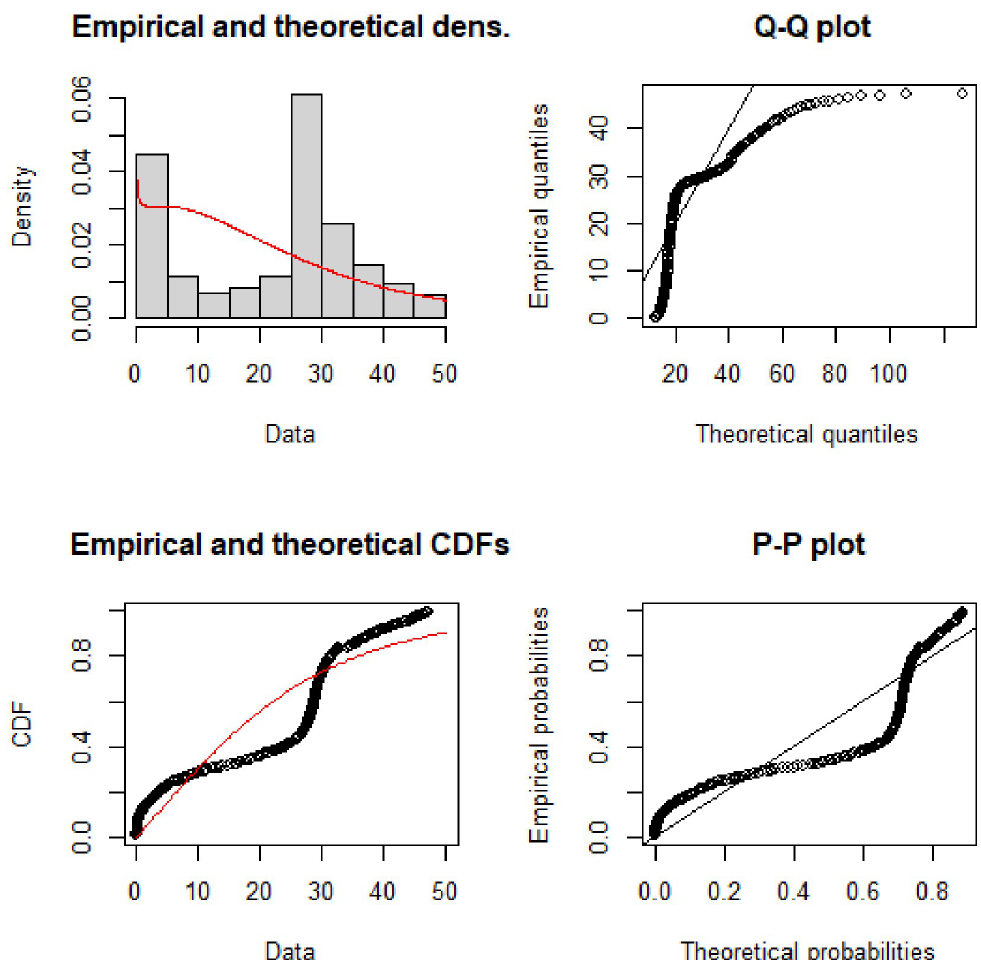
Fig 4. Theoretical and empirical PDF and CDF with Q-Q plot and P-P plot for NFW.